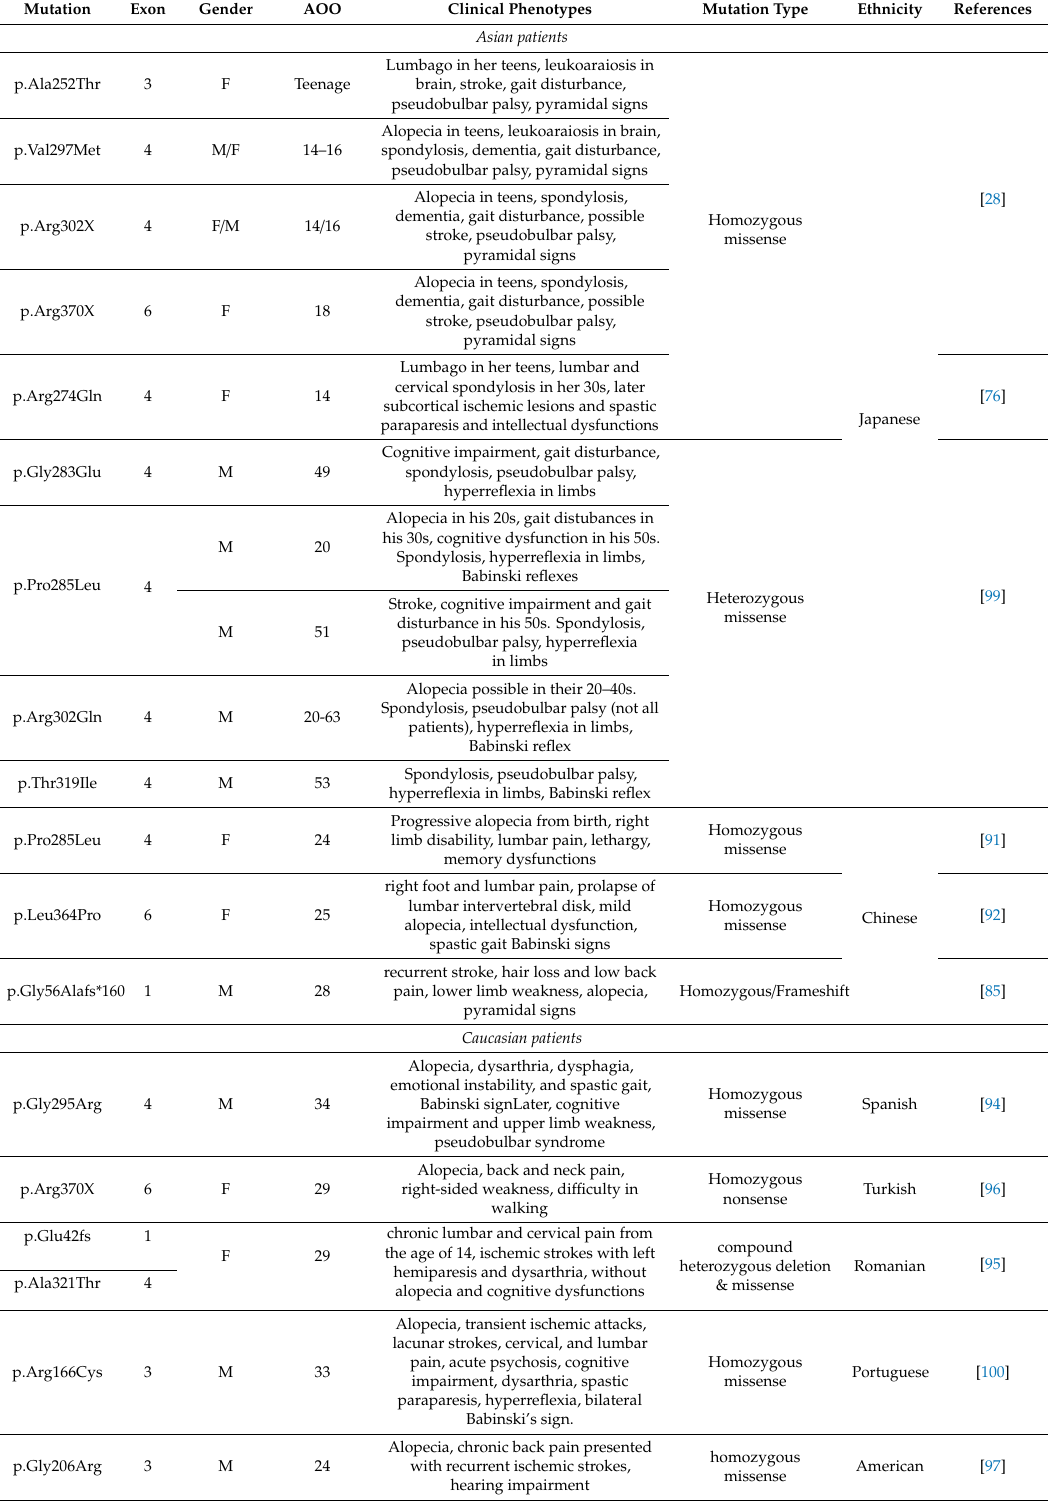
Table 3. HTRA1 mutations in patients with